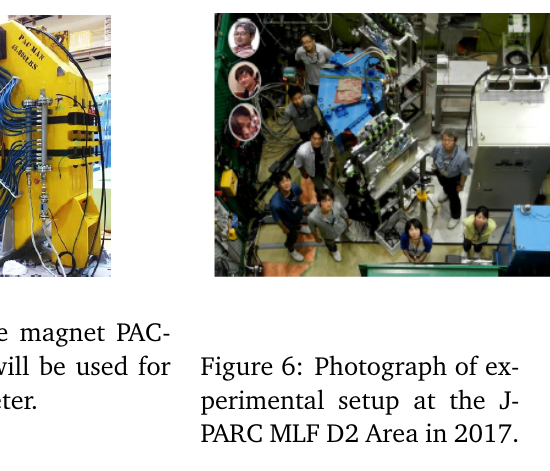
Figure 6: Photograph of ex- perimental setup at the J- PARC MLF D2 Area in